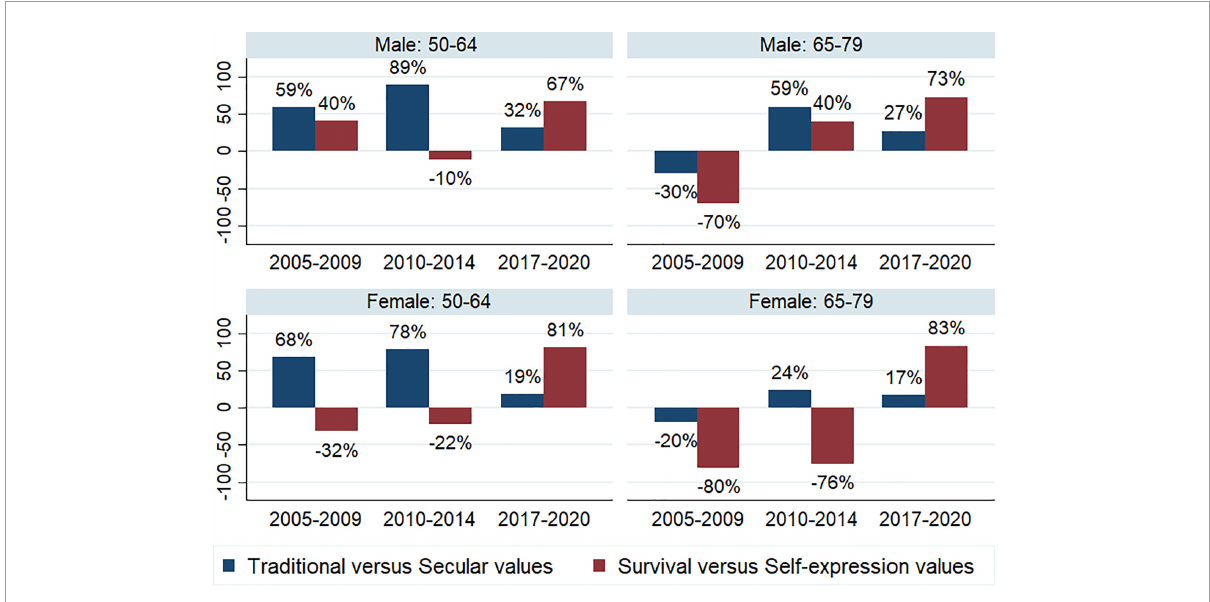
FIGURE1 Values by gender and age, 2005/09, 2010/14, and 2017/20 (Data in percentages). Integrated Values Survey, own